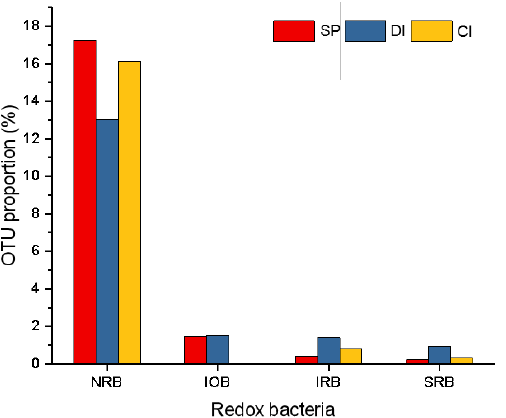
Figure 6. OUT proportions of redox bacteria in different pipe materials. Abbreviations are used for NRB, IOB, IRB, and SRB [48 – 50].